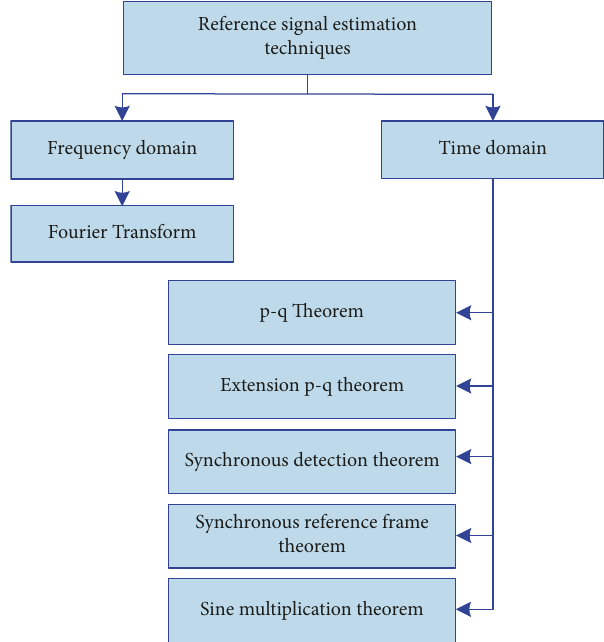
Figure 13: Classification of reference signal estimation